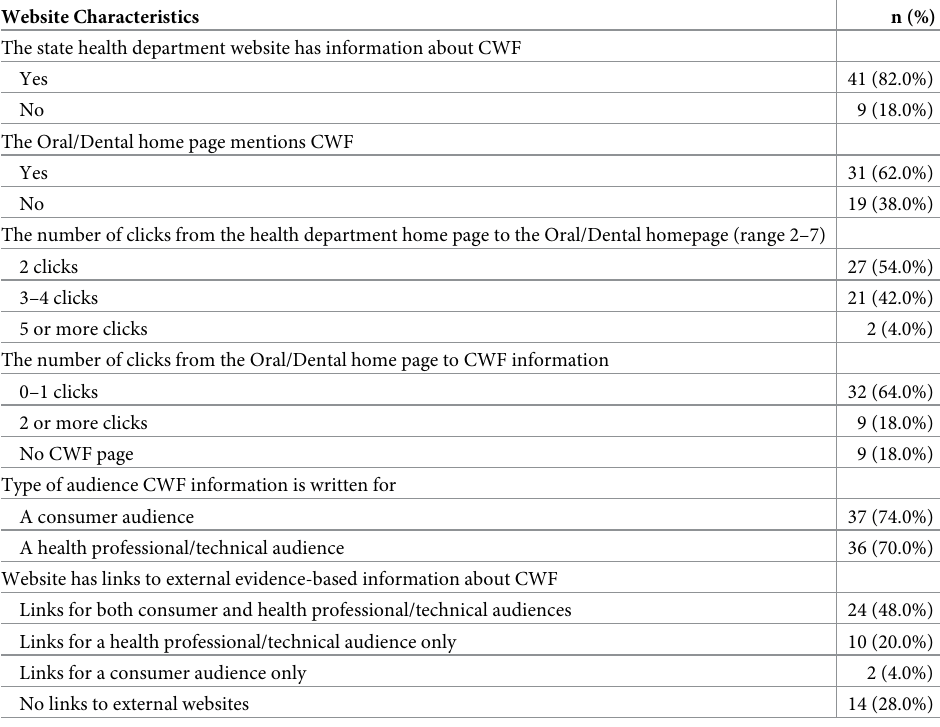
Table 1. U.S. state health department website (N = 50) navigation characteristics relating to community water fluoridation content, August 2019. Website